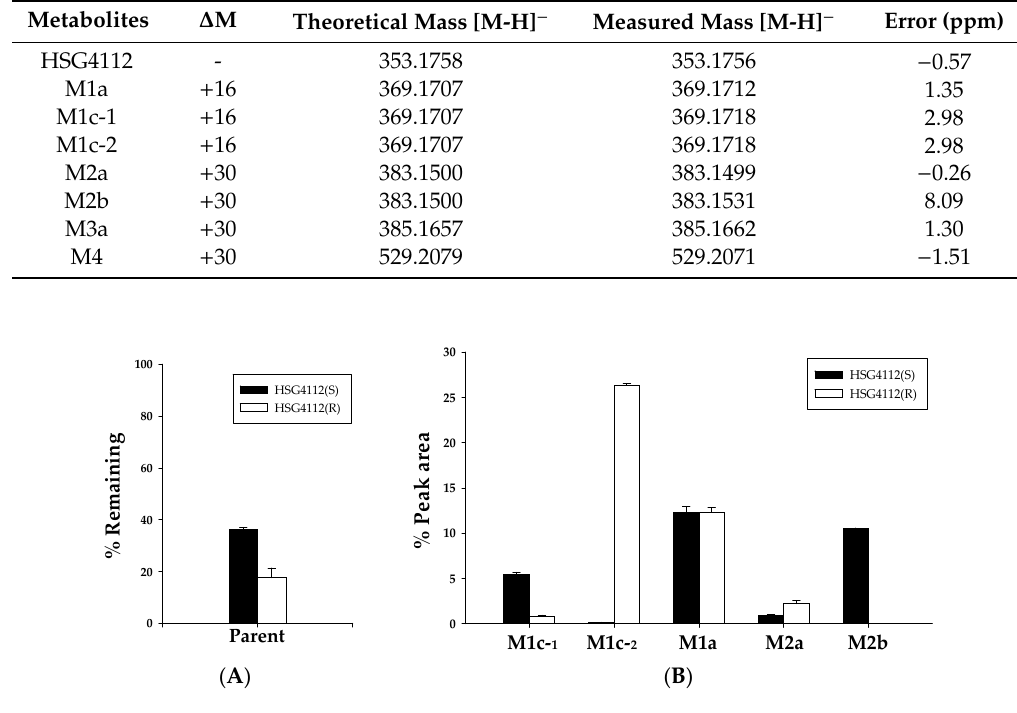
Figure 6. Metabolic profiles of HSG4112(S) and HSG4112(R) in rat liver microsomes. ( A ) Percent remaining amounts of HSG4112(S) and HSG4112(R). ( B ) Relative peak areas of the metabolites generated from HSG4112(S) and HSG4112(R). HSG4112(S) and HSG4112(R) were incubated separately in rat liver microsomes for 60 min and the resulting amount of the parent drug and its metabolites was measured based on peak area.